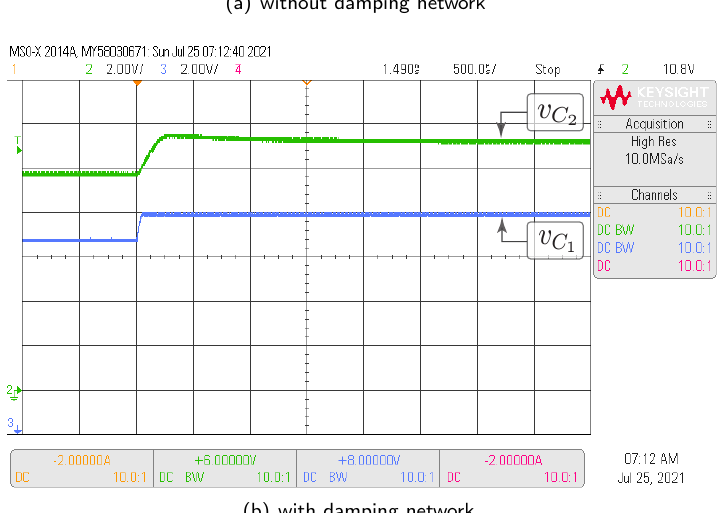
Figure 16. Experimental results for the SEPIC converter with positive magnetic coupling which demonstrate good agreement with HIL results showed in Figure 11: ( a ) without damping network, ( b ) with damping network. (CH2: v C (2 V/div), CH3: v C (2 V/div), and time base of 500 µ 2 1